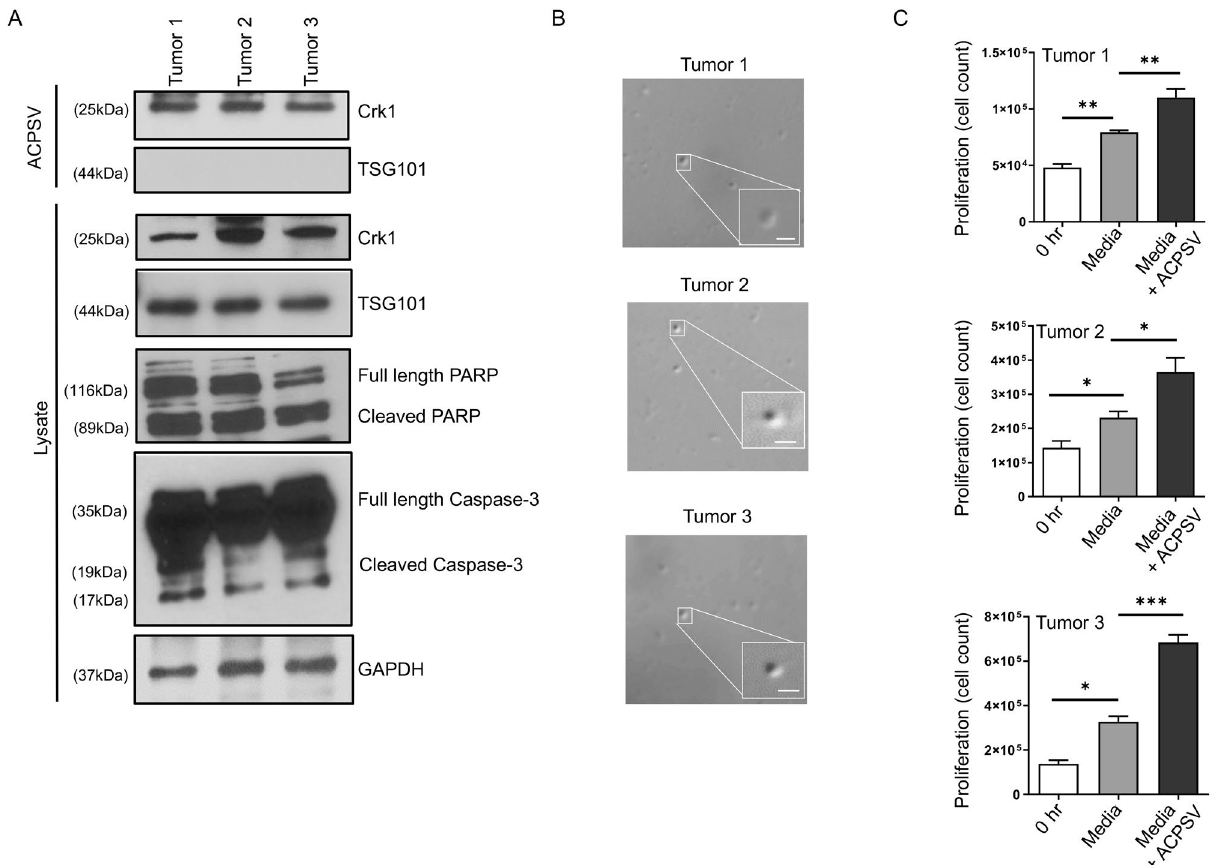
Figure 3. ACPSV production assessment in SCC tumors. (A) Resected tumors from 3 SCC cancer patients were assessed by Western blotting for apoptosis (using caspase-3 and PARP activation), and for their ACPSVs contents (after ACPSV purification from the tumors by differential centrifugation) using ACPSV marker CrkI. The 16K fractions (which contain ACPSVs) were also probed for contaminating exosomes (using exosome marker TSG101). (B) The ACPSVs in the 16K fractions of these tumors were visualized by DIC. (C) The ACPSVs in the 16K fractions of these tumors were assessed for their ability to stimulate proliferation in adherent HeLa cells. (B) Purified ACPSVs from these tumors were visualized by DIC imaging. (A) ; by Western blotting, probing for CrkI (B) ; and for their ability to stimulate proliferation in adherent HeLa cells by cell count 48 h after treatment with ACPSV-containing media or media alone. (N = 3; ns, not significant, *p < 0.01, **p < 0.001, ***p < 0.0001. Statistical analyses between groups were performed by One-way ANOVA with post hoc